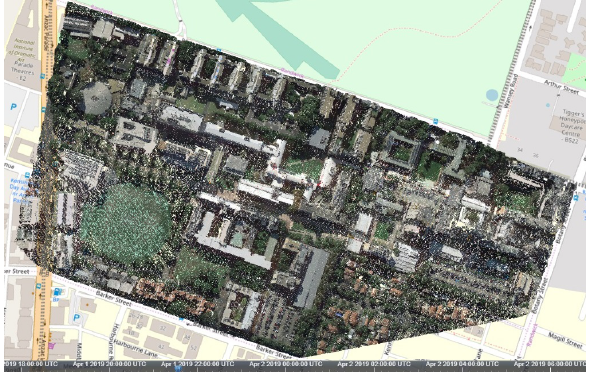
Figure 11. Visualisation of coloured point cloud (approximately 1 million